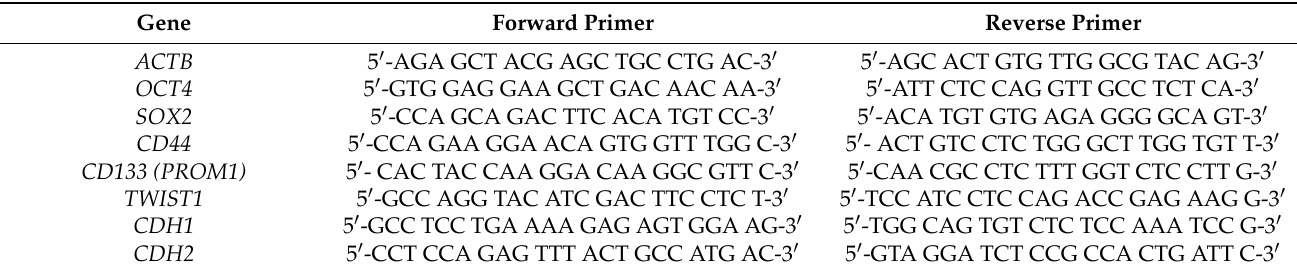
Table 2. List of